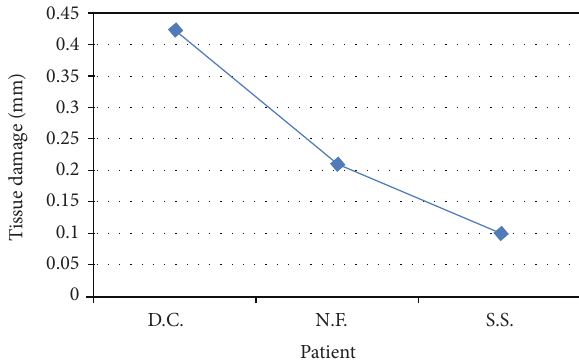
Figure 2: Peri-incisional marginal damage in mucocele.